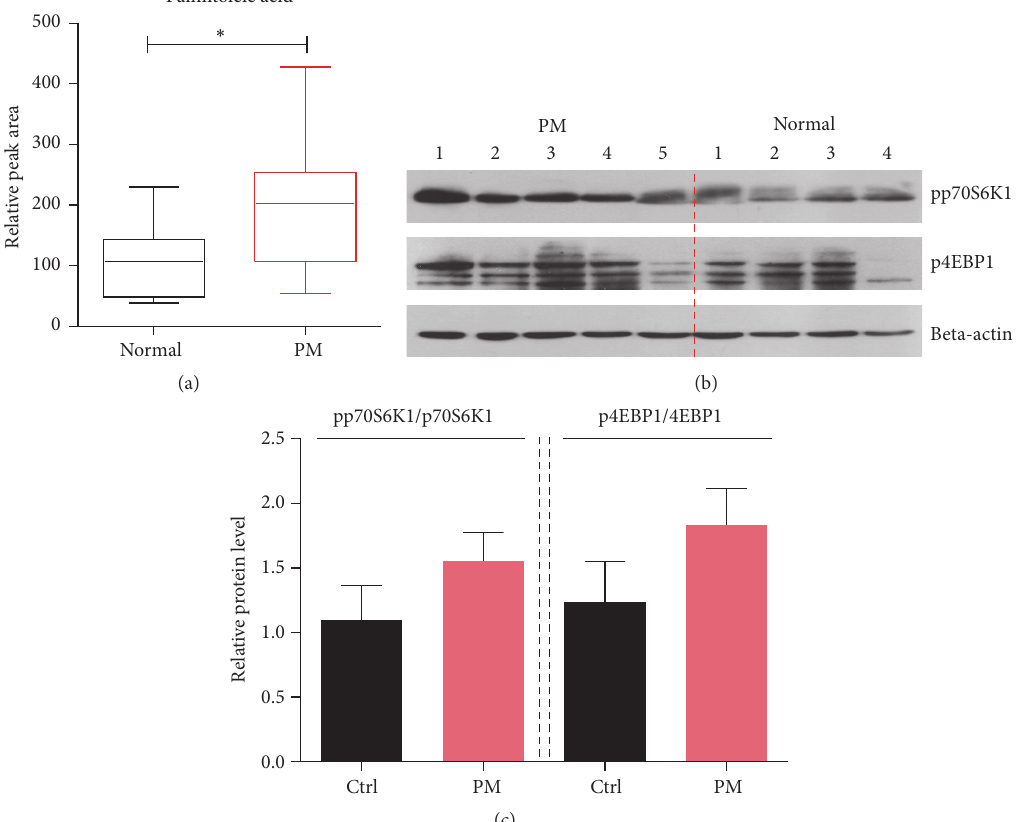
Figure 4: Increased palmitoleic acid as a biomarker of PBMC in patients with polymyositis. (a) LC-MS results showed the increasing of palmitoleic acid level in PBMC of polymyositis (PM) patients compared with normal ones. Results come from 12 normals and 16 PM patients. Data represent mean with min. to max. ∗ 𝑝 < 0.05 . (b and c) Western blots and quantification showed that mTORC1 activity, indicated by pp70S6K1 and p4EBP1, was increased in PBMC of polymyositis (PM) patients compared with normal ones. Results are averages of nine independent experiments. Data represent mean ±